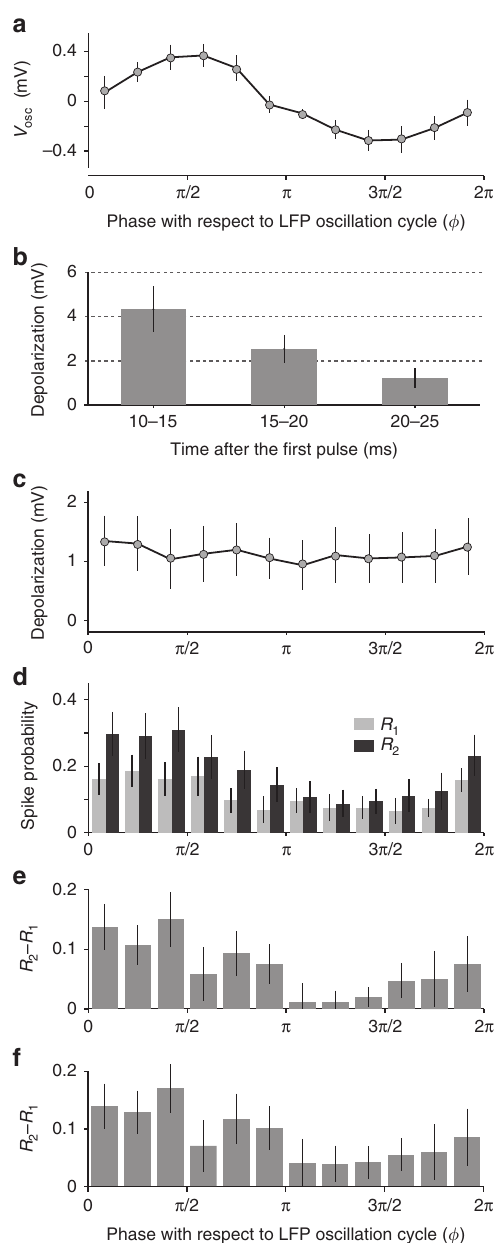
Figure 2 | KCs have cyclic integration windows. ( a ) Average membrane potential plotted as a function of the LFP phase ( f ) shows robust subthreshold oscillations ( V osc ) with upward deflections in the first half of the cycle; n ¼ 16 KCs, error bars: s.e.m. ( b ) Residual depolarization in different time intervals after the onset of the first pulse (the pulse ends at 5ms). ( c ) Residual depolarization in the 20–25ms interval after the first pulse (that is, just before the onset of the second pulse) did not depend on the phase of the oscillation cycle. ( d ) Spiking responses (mean ± s.e.m.) evoked by the first and the second current pulses, R 1 ( f ) and R 2 ( f ), respectively, are most likely to occur in the first half of the cycle. ( e ) Phase-dependent summation is measured by comparing responses to the first pulse ( R 1 ( f )) and the second pulse ( R 2 ( f )) occurring at the same phase (not to the two pulses in the same pair). The effect of summation, R 2 ( f ) (cid:2) R 1 ( f ), is most effective in the first half of the cycle. ( f ) To test possible contributions of after- hyperpolarizations to phase-dependent summation, R 2 ( f ) (cid:2) R 1 ( f ) was computed after excluding responses to pairs of pulses in which the first pulse evoked a spike. This data set lacking after-hyperpolarizations also showed robust phase-dependent summation. All error bars represent s.e.m.